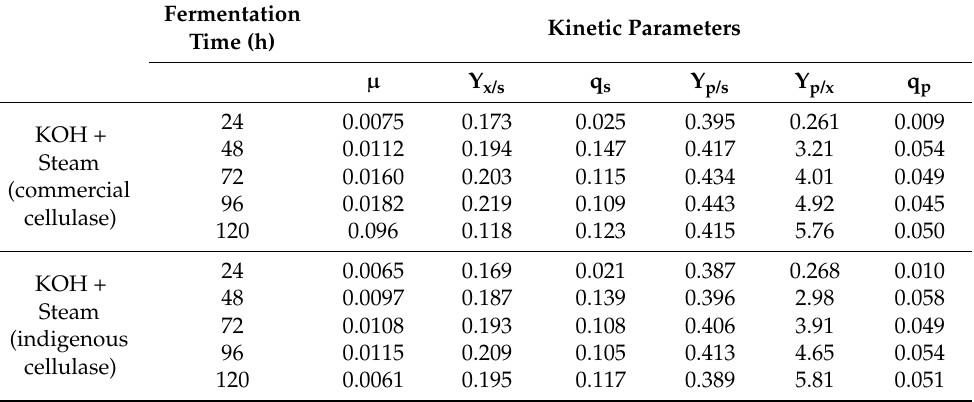
Table 5. Kinetic parameter estimation for ethanol fermentation in separate hydrolysis and fermenta- tion